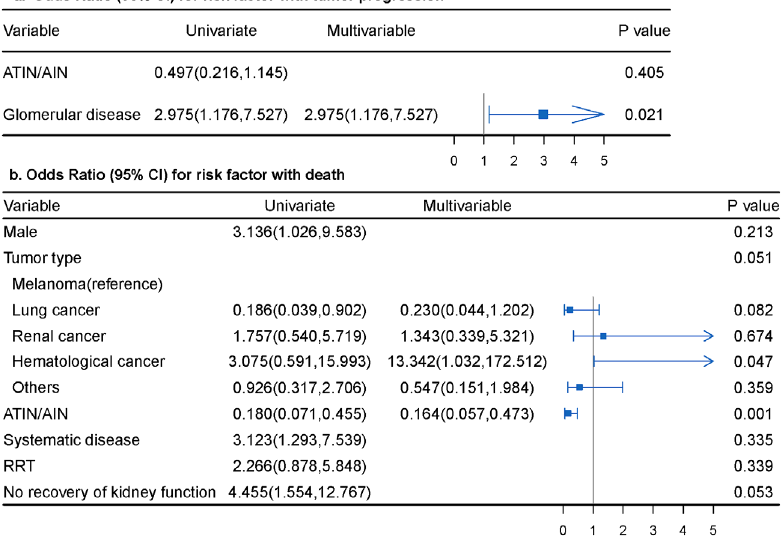
Figure 4. Univariate logistic analysis of factors associated with tumor progression and death. ( a ) Risk factors associated with tumor progression; ( b ) risk factors associated with death. ATIN/AIN: acute tubulointerstitial nephritis/acute interstitial nephritis; CI: confidence interval; RRT: renal replacement treatment.